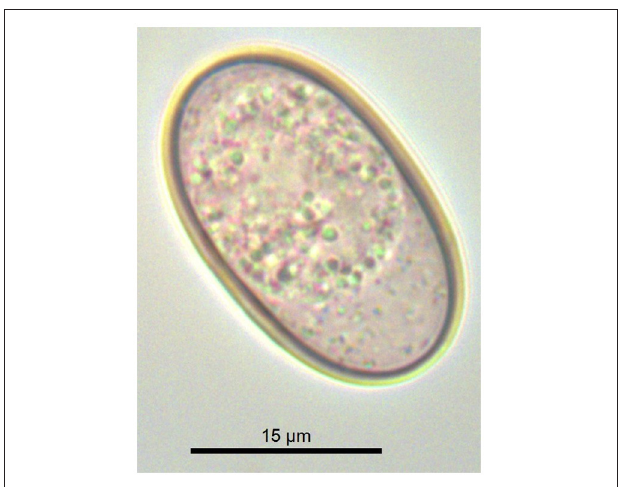
FIGURE 1 | Unsporulated oocyst of Eimeria sciurorum from the feces of the Calabrian black squirrel ( Sciurus meridionalis ).